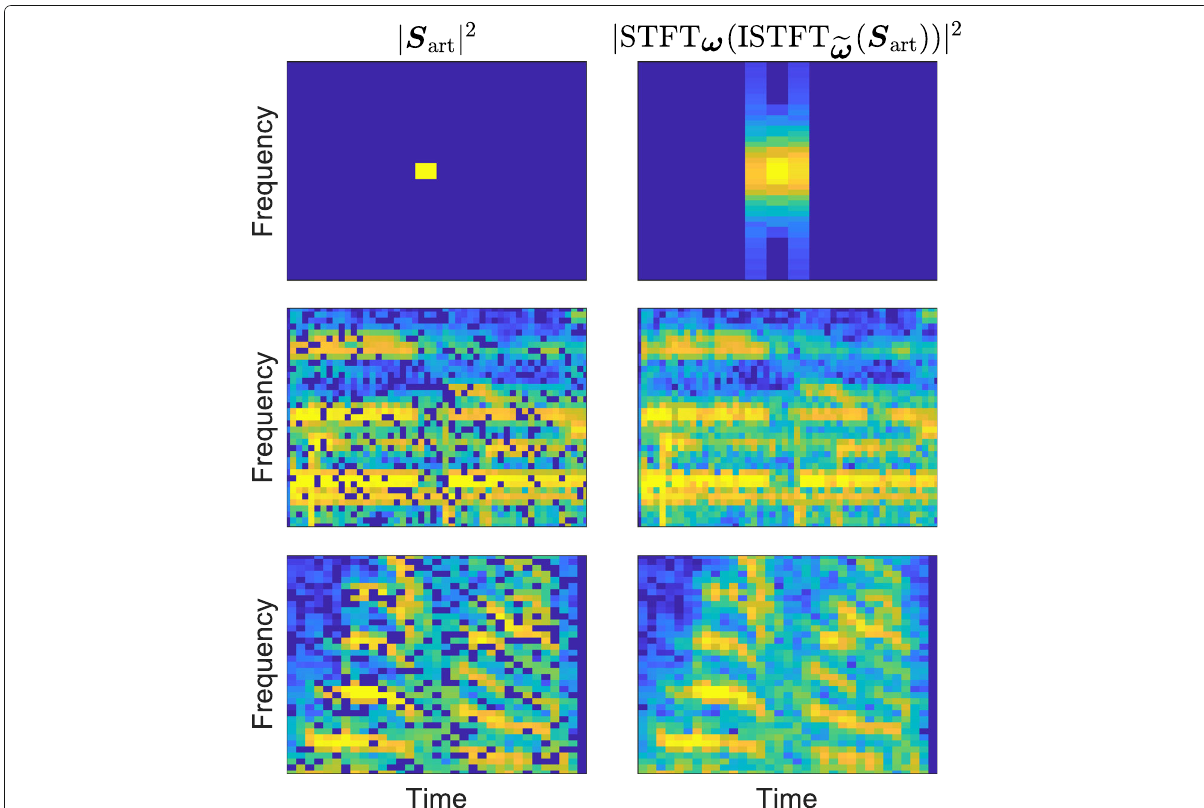
Fig. 1 Inconsistent power spectrograms | S art | 2 (left column) and their consistent version (right column) obtained by applying inverse STFT and STFT. The top-left spectrogram is artificially produced with random phase. The middle-left and the bottom-left spectrograms are music and speech signals with random dropout. Enforcing spectrogram consistency can be viewed as a smoothing process of the inconsistent spectrogram along both time and frequency